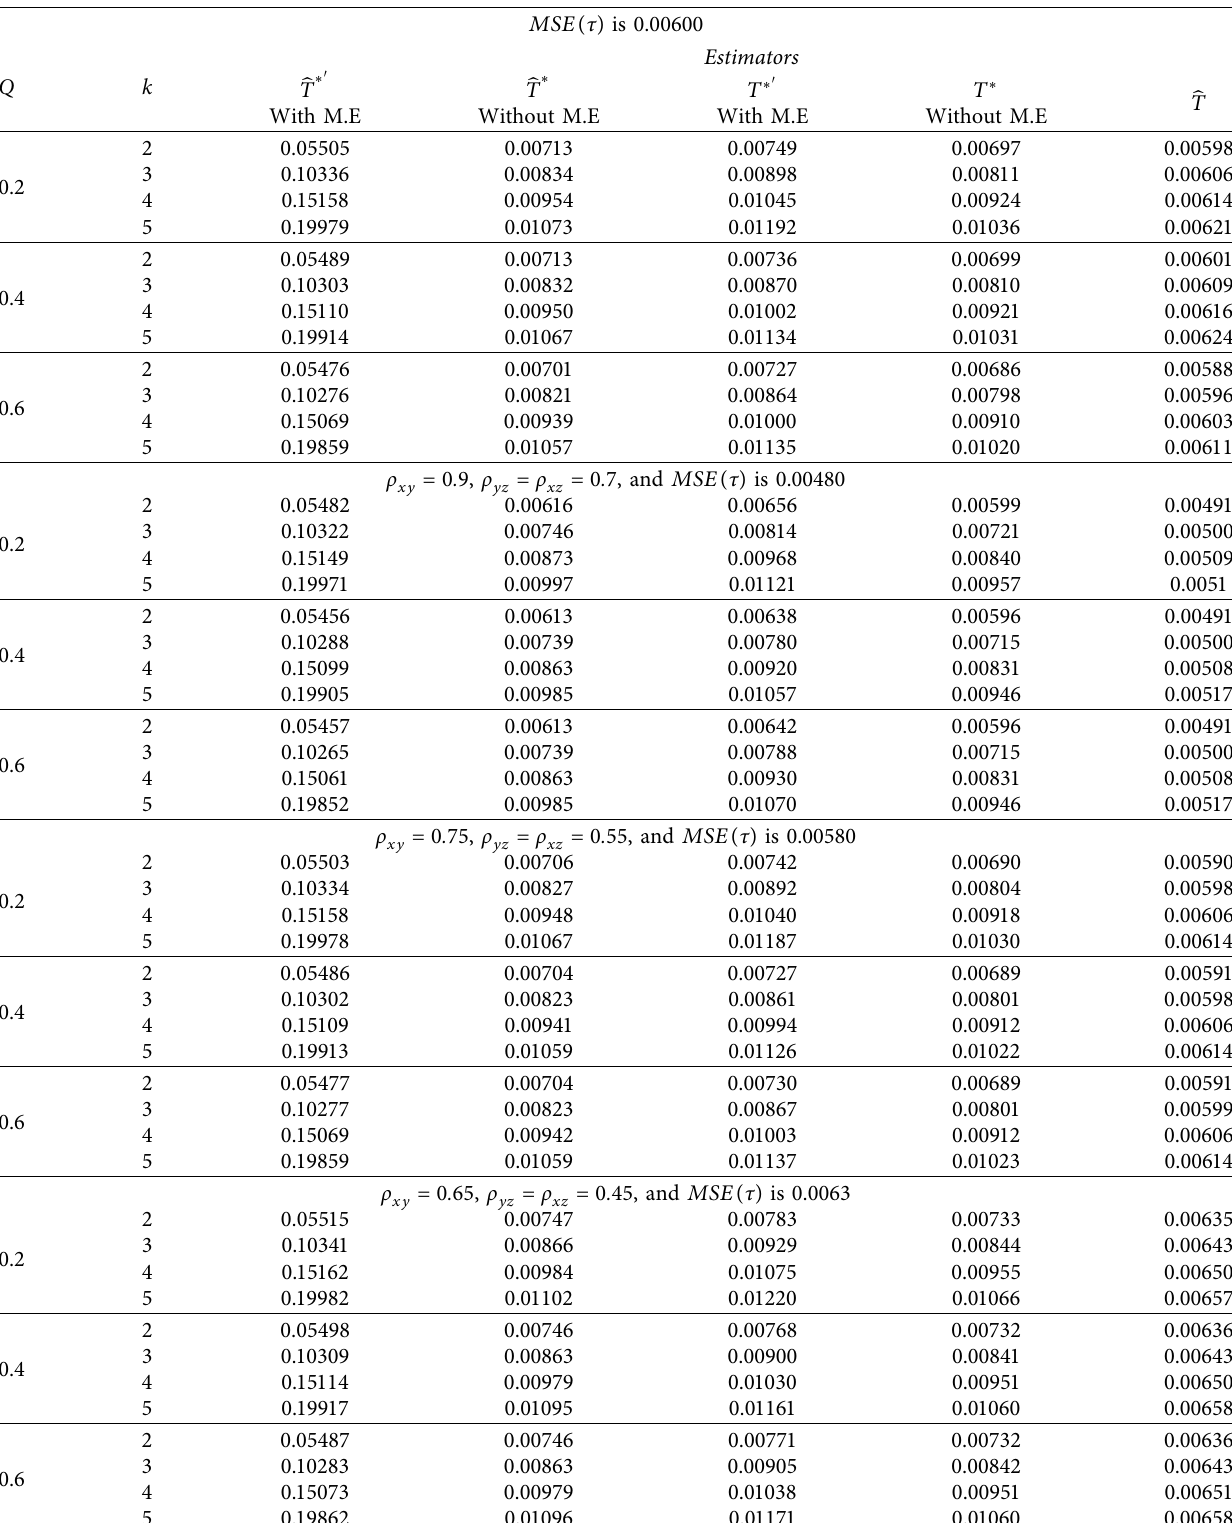
Table 1: MSE of the proposed estimators with nonresponse and measurement errors for W � 0 . 4 and diferent values of k and q